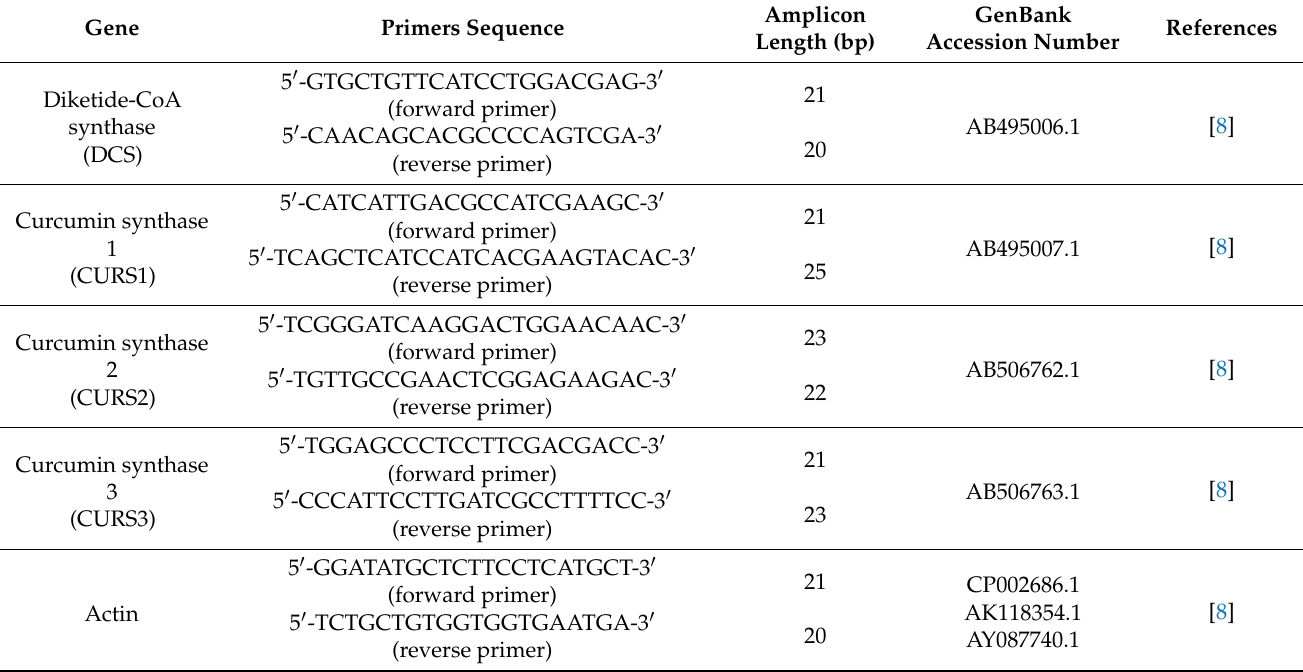
Table 3. Sequences of forward and reverse primers for real-time